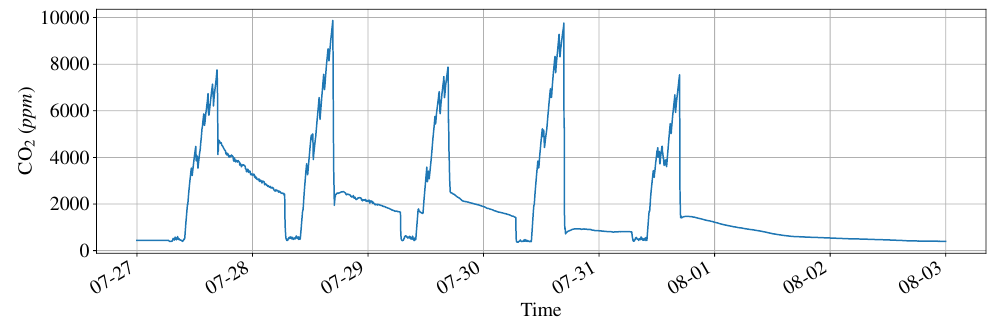
Figure 5. Weekly CO 2 concentration.